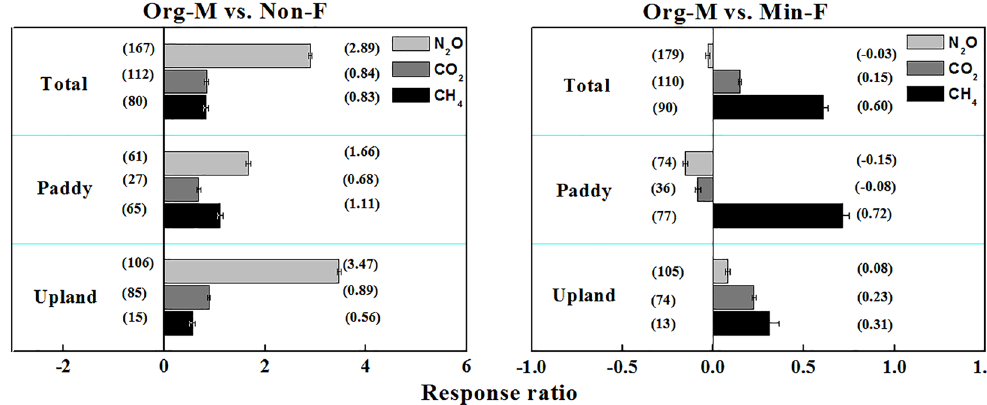
Figure 2. N 2 O, CO 2 and CH 4 emissions (CH 4 emission for paddies and uptake for upland) affected by manure application compared to Non-F (left panel) and Min-F (right panel). Numbers near the bars at the positive side of x axis are the RR ++ and the numbers at the negative side of x axis are the numbers of comparisons. P < 0.05, when error bars do not overlap